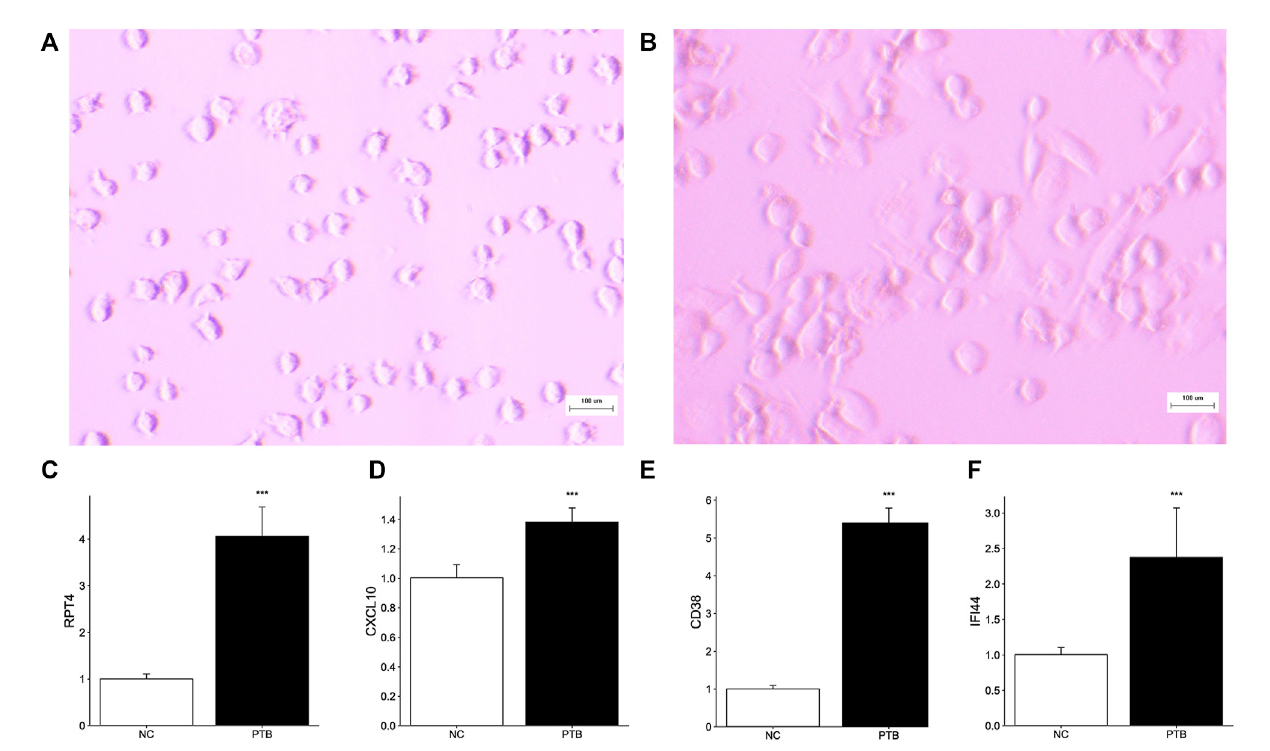
FIGURE 6 Effect of M. tuberculosis-BCG on THP-1 cells. The microscope images of (A) THP-1 cells, and (B) PMA successfully induced THP-1 cells adhered and differentiation.Whitescalebar,100 μ m. (C – F) THP-1cellswereinfectedwithBCGfor24 h.ExpressionlevelofRTP4,CXCL10,CD38,andIFI44weretestedby qRT-PCR (Data are mean ± SD of 3 separate experiments, * p < 0.05, ** p < 0.01, *** p <